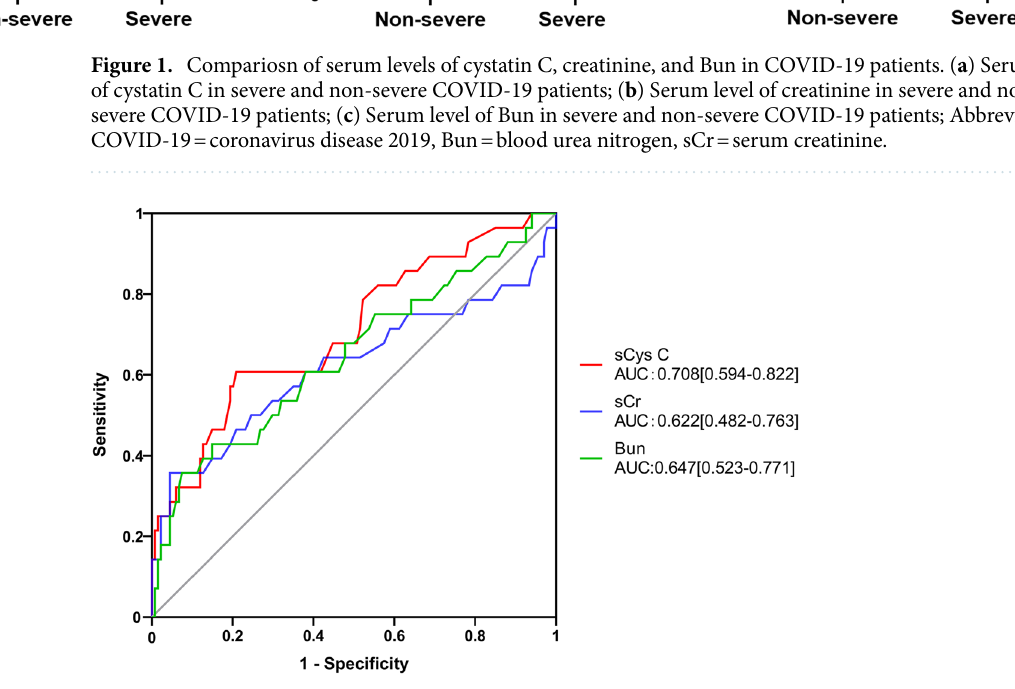
Figure 2. Predictive performances of sCys C, Bun, and sCr using ROC analysis. Comparison of predictive performances of sCys C, Bun, and sCr. Abbreviations: COVID-19 = coronavirus disease 2019, sCys C = serum cystatin C, Bun = blood urea nitrogen, sCr = serum creatinine, ROC = receiver operating characteristic